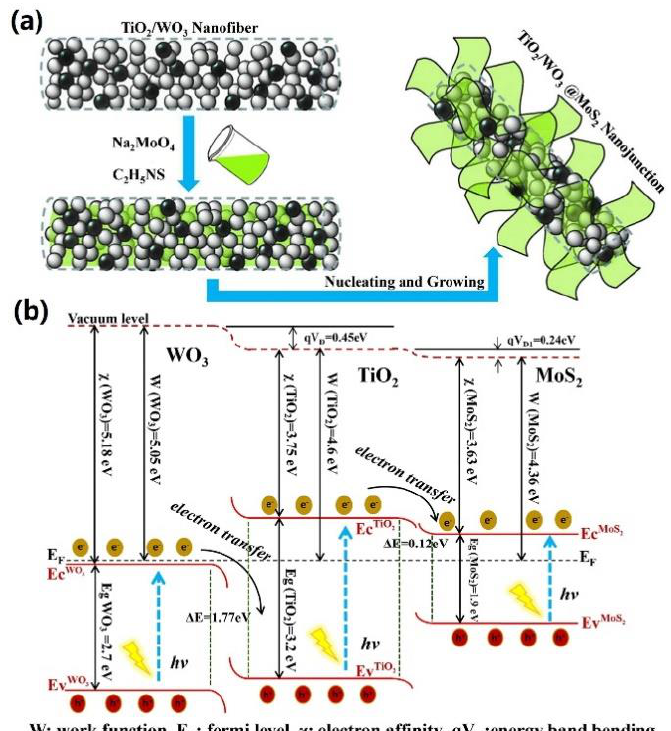
Figure 22. ( a ) Schematic illustration for the growth of MoS 2 nanosheets ( b ) Schematic diagram of the photocatalytic H 2 generation over the ternary TiO 2 /WO 3 @MoS 2 heterostructure composite. Reprinted with permission from [137]. Copyright 2017, Elsevier.